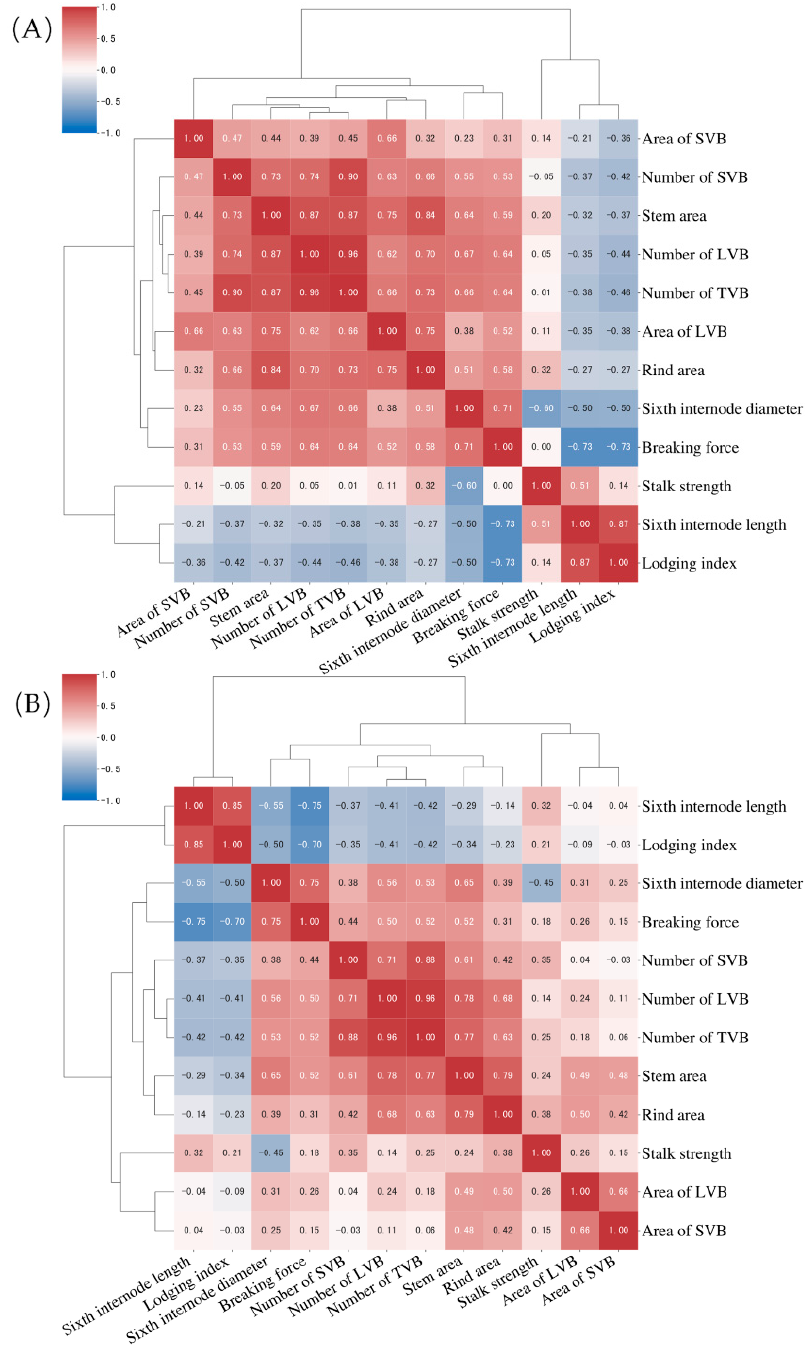
Figure 2. Heat-map showing the correlation of stalk mechanical properties with the stem cross-sectional parameters in sorghum germplasm: ( A ) first season (df = 51, r 0.05 = 0.271); ( B ) second season (df = 56, r 0.05 = 0.269).